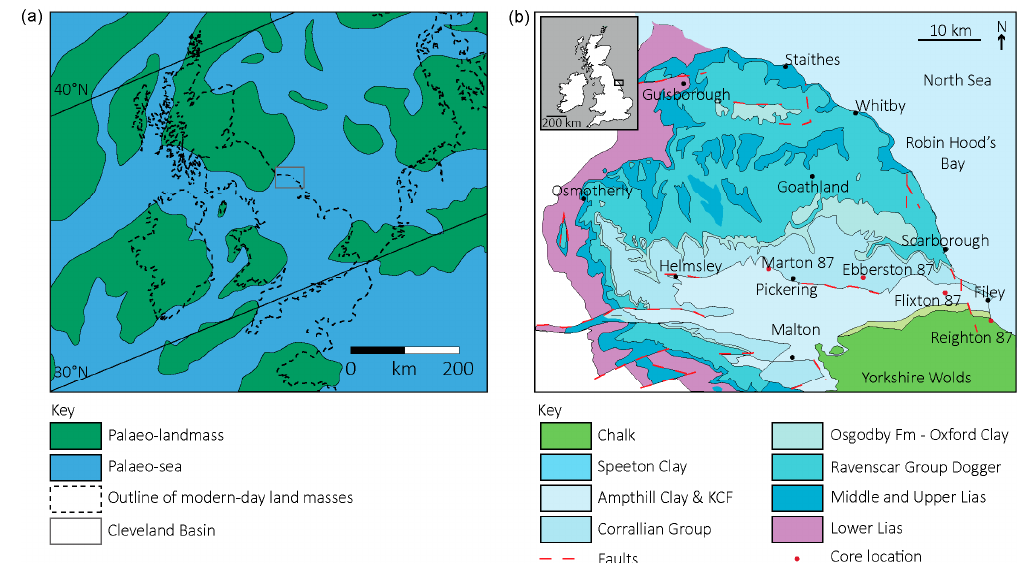
Figure 1. ( a ) Palaeogeographic map of North West Europe during the Kimmeridgian stage modified from Turner et al. (2019) [36] reproduced with permission after Atar et al. (2019b) [15]. ( b ) Geological map of the Cleveland Basin (Yorkshire, UK) after Powell (2010) [52], reproduced with permission after Atar et al. (2019a) [14]. The Marton 87, Ebberston 87, Flixton 87, and Reighton 87 cores are marked by red dots on the map .